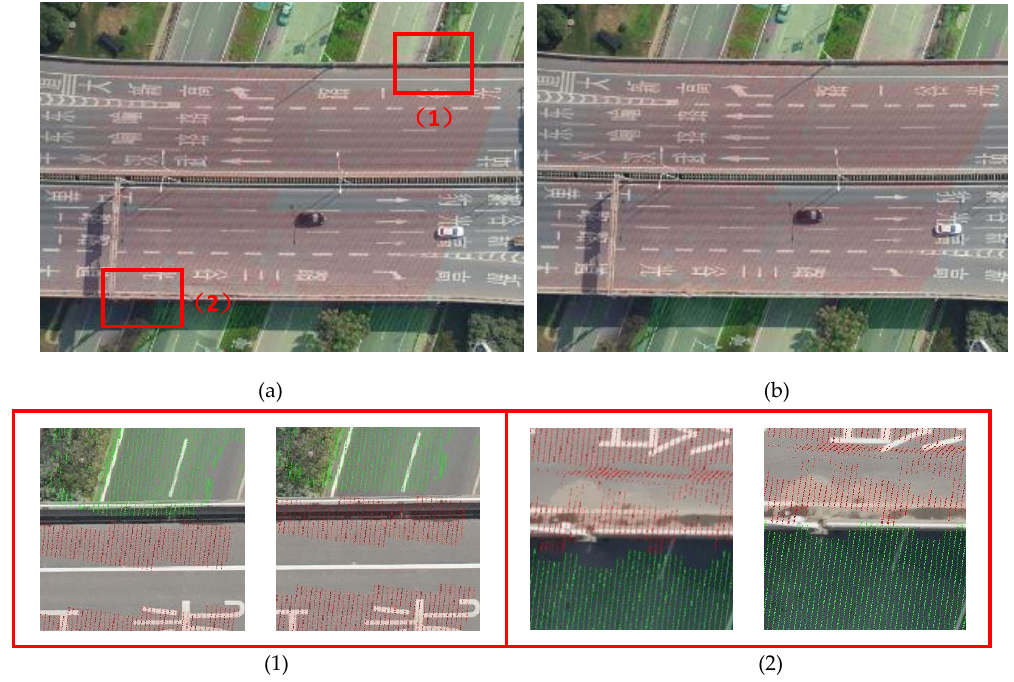
Figure 10. Overpass point back projection: (a) Before LiDAR constrain; (b) After LiDAR constrain Using the characteristics of obvious contrast between road markings and asphalt pavement, the effectiveness of this method can also be verified by the deviation of road markings. In the LiDAR point cloud, three kinds of common road markings, i.e., “entry entrance line”, “diverging line”, and “indicating arrow” are selected and back projected, and the projected points are colored according to LiDAR point cloud intensity. The contrast between the projection results before and after the LiDAR point cloud constraint is shown in Figure 11. Before the LiDAR point cloud constraint, the projected points of the road markings are significantly shifted. After the LiDAR point cloud constraint, the projection point offset is very small, with an offset of about 3-5 pixels. The coincidence accuracy is significantly improved.